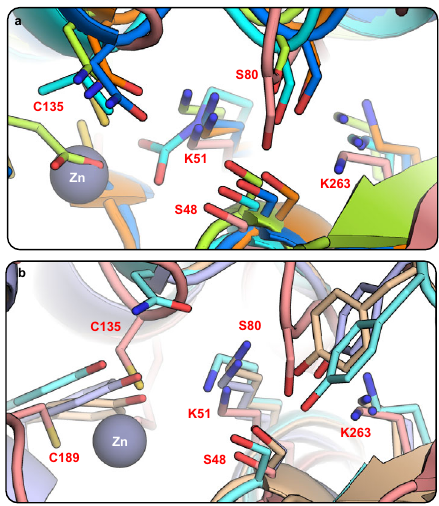
Fig. 8 Superposition of the catalytic centers of ReAV (salmon, red residue numbers) and selected structural homologs (identi fi ed by their PDB codes and color). a β -Lactamases from K. pneumoniae (cyan, 6v1o, the counterpart of K51 is acetylated) and P. aeruginosa (light green, 5eua); peptidoglycan glycosyltransferase from A. parvulum (blue, 4r1g); PBP form N. gonorrhoeae (orange, 6hzj). All these proteins possess two Ser-Lys tandems in the active site. b In some structural homologs of ReAV, Ser80 is replaced by Tyr, e.g., glutaminase from B. subtilis (violet, 1mki), human liver- type glutaminase (wheat, 4bqm) and kidney-type mouse glutaminase (light cyan, 4jkt). The gray sphere marks the Zn cation in the ReAV